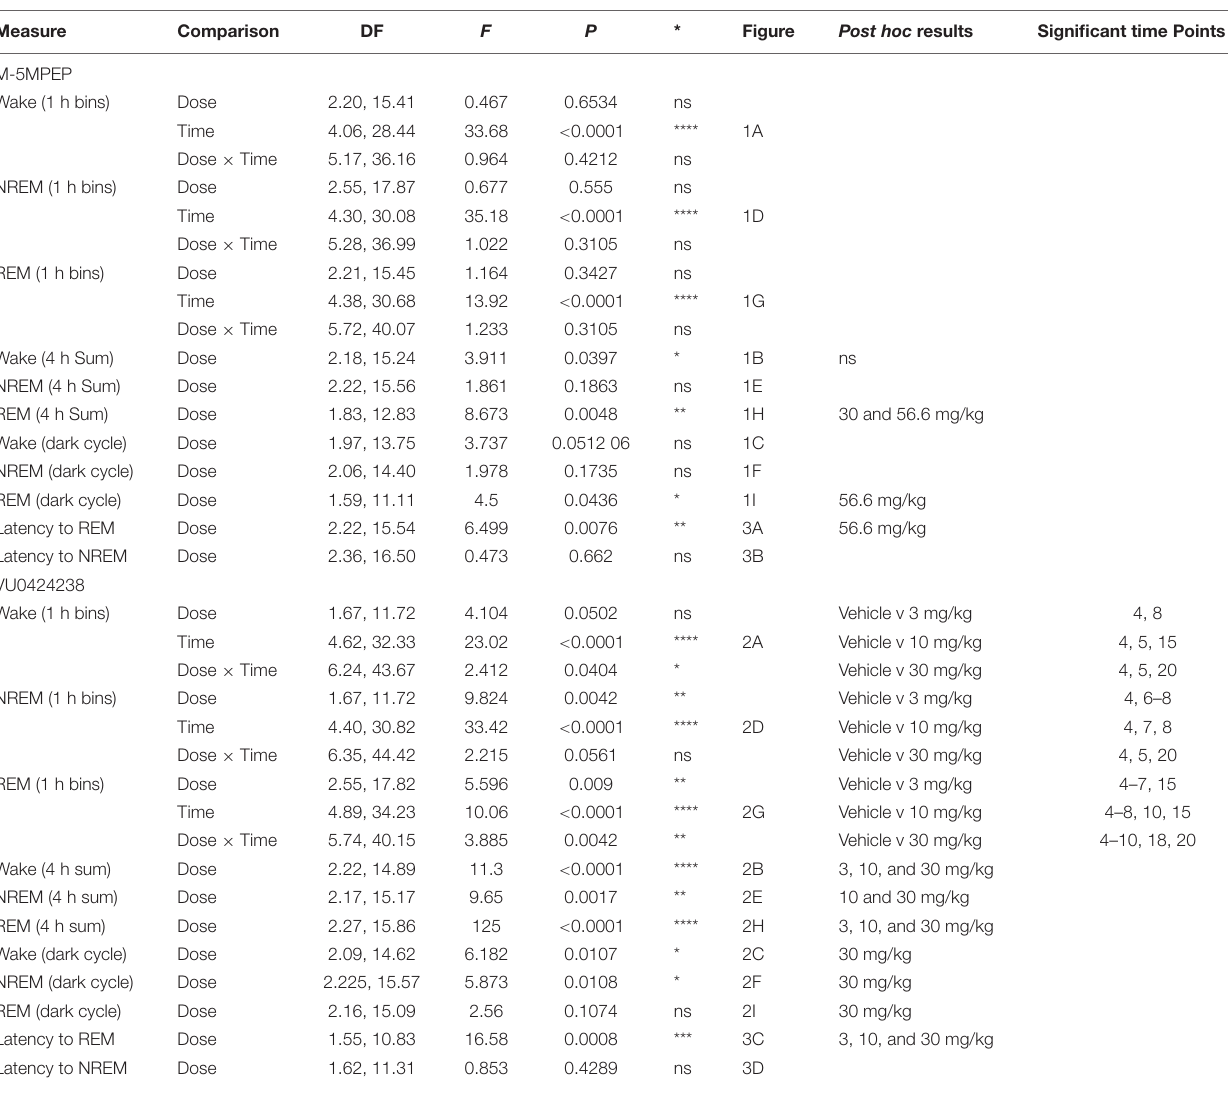
Figure Post hoc